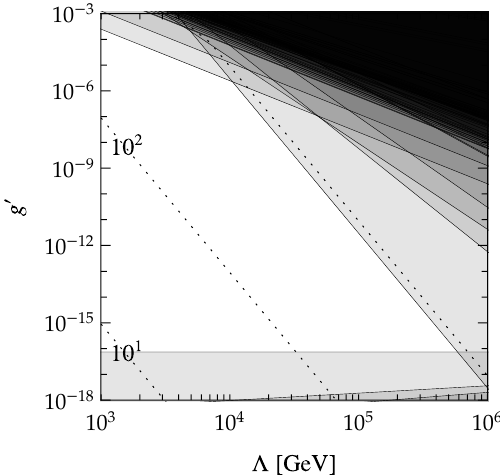
Figure 22 . Same region as in (cid:12)gure 17 (fragmentation during in(cid:13)ation) where we show the contours of the minimum (left) and maximum (right) values of the scale (cid:3) b in GeV. The maximal value of (cid:3) b is, in the region of interest, always equal to p 4 (cid:25)v , as required by eq. (3.6). EW